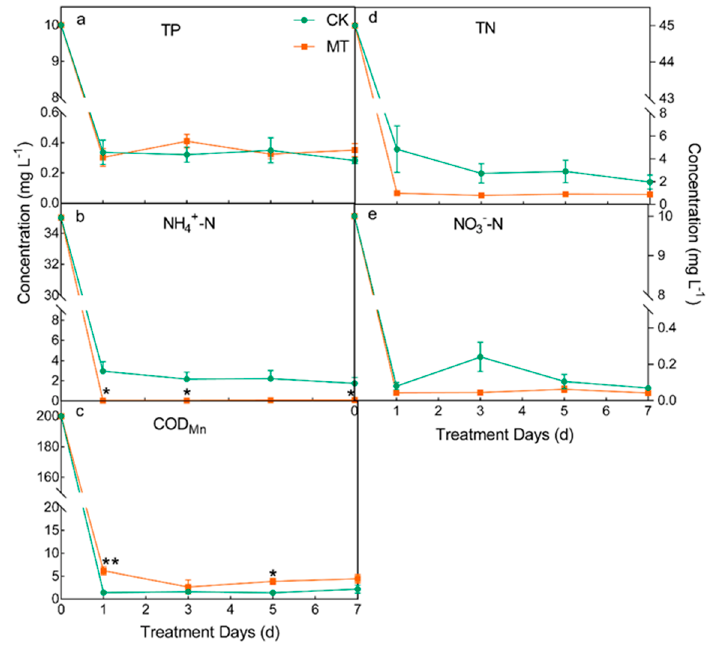
Figure 1. Effluent concentrations of TP ( a ), NH 4+ -N ( b ), COD Mn ( c ), TN ( d ), and NO 3 − -N ( e ) in the control (CK) and melatonin (MT). TP, total phosphorus; NH 4+ -N, ammonia nitrogen; COD Mn , chemical oxygen demand; TN, total nitrogen; NO 3 − -N, nitrate nitrogen. “ns” indicates not significant, “*” indicates significance at p < 0.05, and “**” indicates significance at p < 0.01. Data are expressed as means ± SE (n = 3).